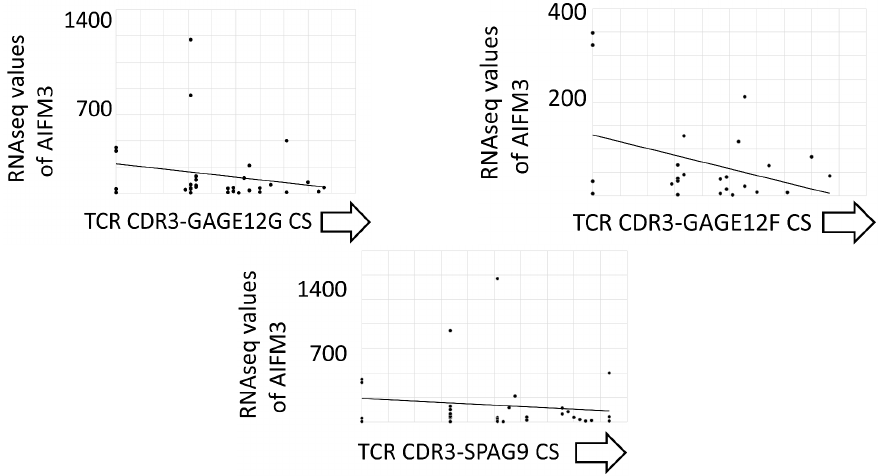
Figure 3. Inverse correlation of AIFM3 gene expression and electrostatic CSs for TCR CDR3-CTAs, SPAG9, GAGE12G, and GAGE12F. (See also Table 2; Table S9).